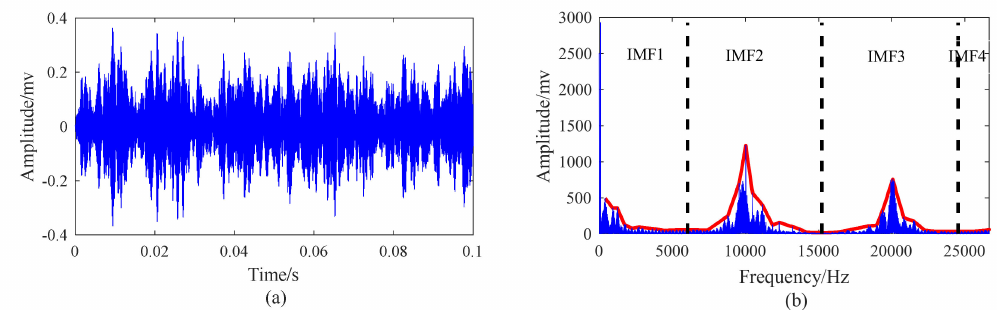
Figure 15. The result of simulation signal of bearing with inner race fault processed by the MCKD-EWT method: ( a ) waveform of signal processed by MCKD; ( b ) Fourier spectrum segmentation results of Improved EWT method.